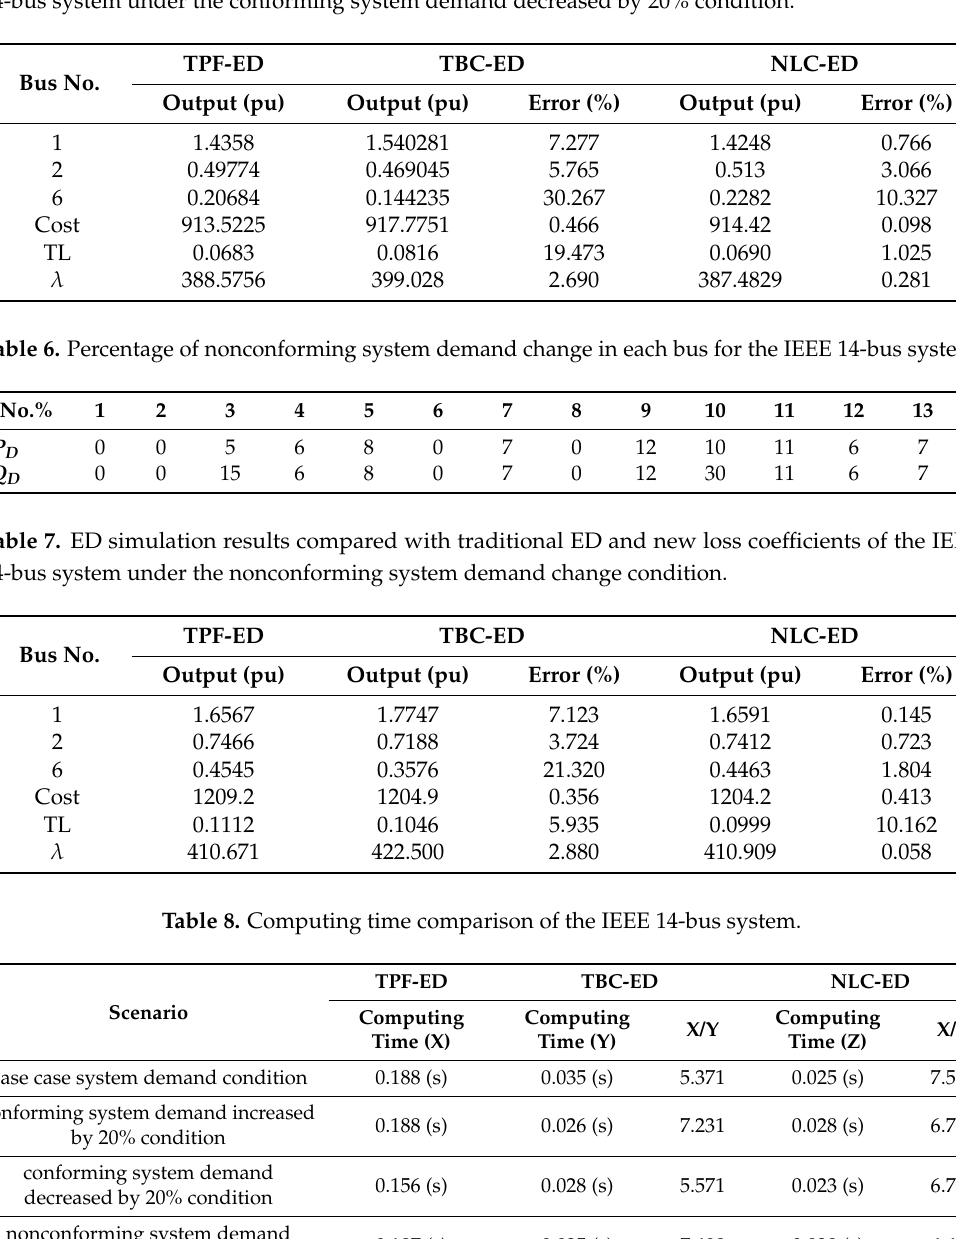
Table 5. ED simulation results compared with traditional ED and new loss coefficients of the IEEE 14-bus system under the conforming system demand decreased by 20% condition.